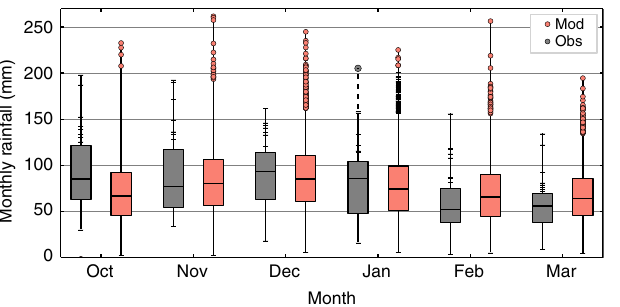
Fig. 3 Unprecedented monthly rainfall in all winter months. South east England monthly rainfall totals from observations ( grey ) and the model ( red ) for October to March. The box represents the interquartile range and the range of the whiskers represents the minimum and maximum monthly rainfall totals. Red dots indicate model months with greater total rainfall than has yet been observed and ticks on the upper observations line indicate values in the upper quartile of events. For January the ticks on the model line indicate months above the observed record prior to 2014 and the grey dot above the observations indicates the record observed monthly rainfall of January 2014 The skewness and kurtosis measure the shape of the distribution — the symmetry and weighting of the tails. If any of the four